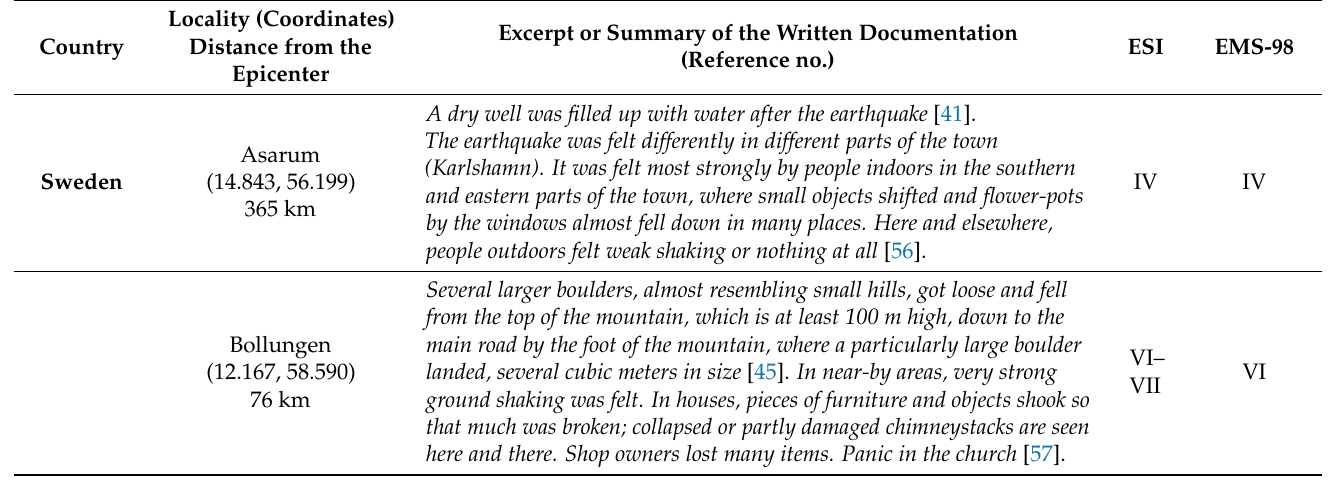
Table 2. Environmental seismic intensities and intensities on the European Macroseismic Scale for the earthquake of 23 October 1904 in Fennoscandia, northern Europe (the coordinates of the localities are given as longitude ◦ E and latitude ◦ N).